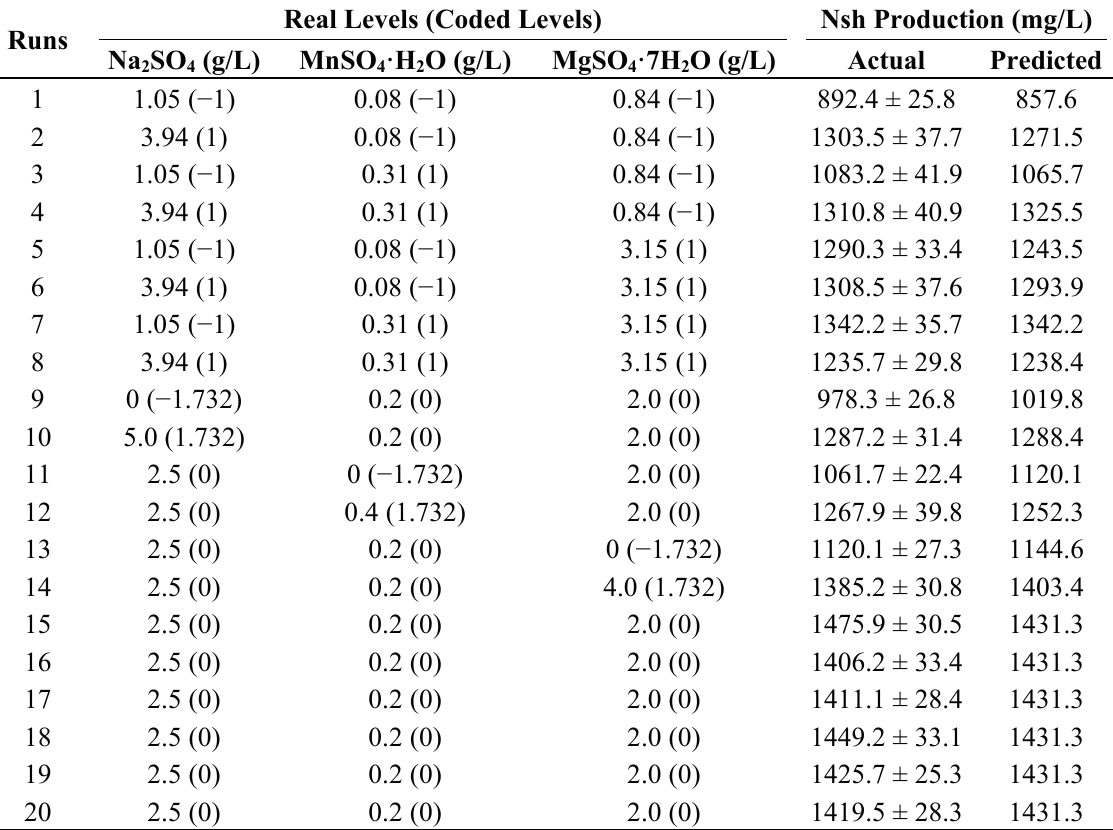
Table 3. Central composite experiment design with the three significant variables and Nsh production.